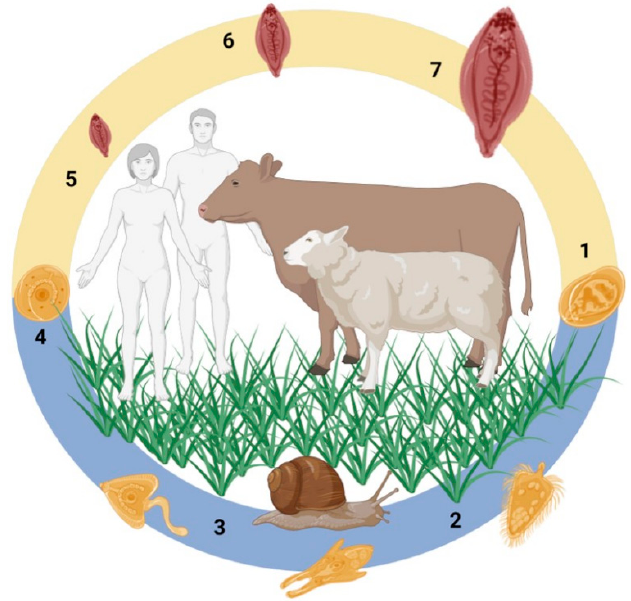
Figure 1. Fasciola spp. life cycle. (1) Eggs are passed in the faeces and undergo embryonation following appropriate temperature and moisture levels. (2) Following embryonation, the miracidia hatch from the eggs and search out the snail intermediate host. (3) Within the snail, the parasites undergo clonal expansion, developing through the rediae, sporocysts and cercariae stages. (4) The cercariae emerge from the snail following light and temperature cues and encyst as metacercariae that are observed on vegetation and floating in water. The metacercariae are the infectious stage that are ingested by the mammalian definitive host. (5) Following ingestion, the metacercariae excyst in the duodenum as Newly Excysted Juveniles (NEJ) that migrate across the gut wall via the peritoneal cavity to the liver. (6–7) Once in the liver, the immature flukes rapidly grow and develop while migrating through the liver parenchyma to the bile ducts, where the mature adult parasites reside, releasing thousands of eggs per day. Figure created using Biorender; Parasite medical art provided by Les Laboratories Servier, https://smart.servier.com, accessed 30 August 2022.